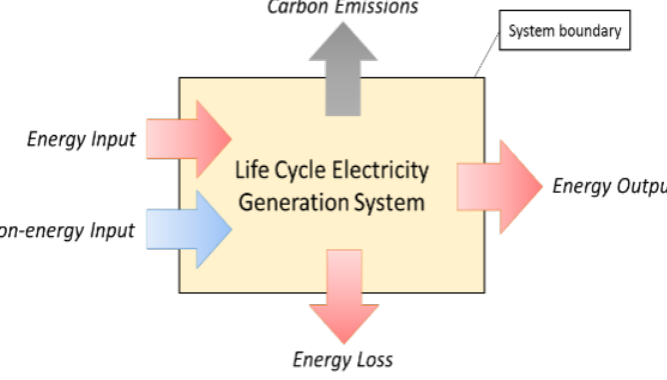
Figure 1. A generic power generation system representation.